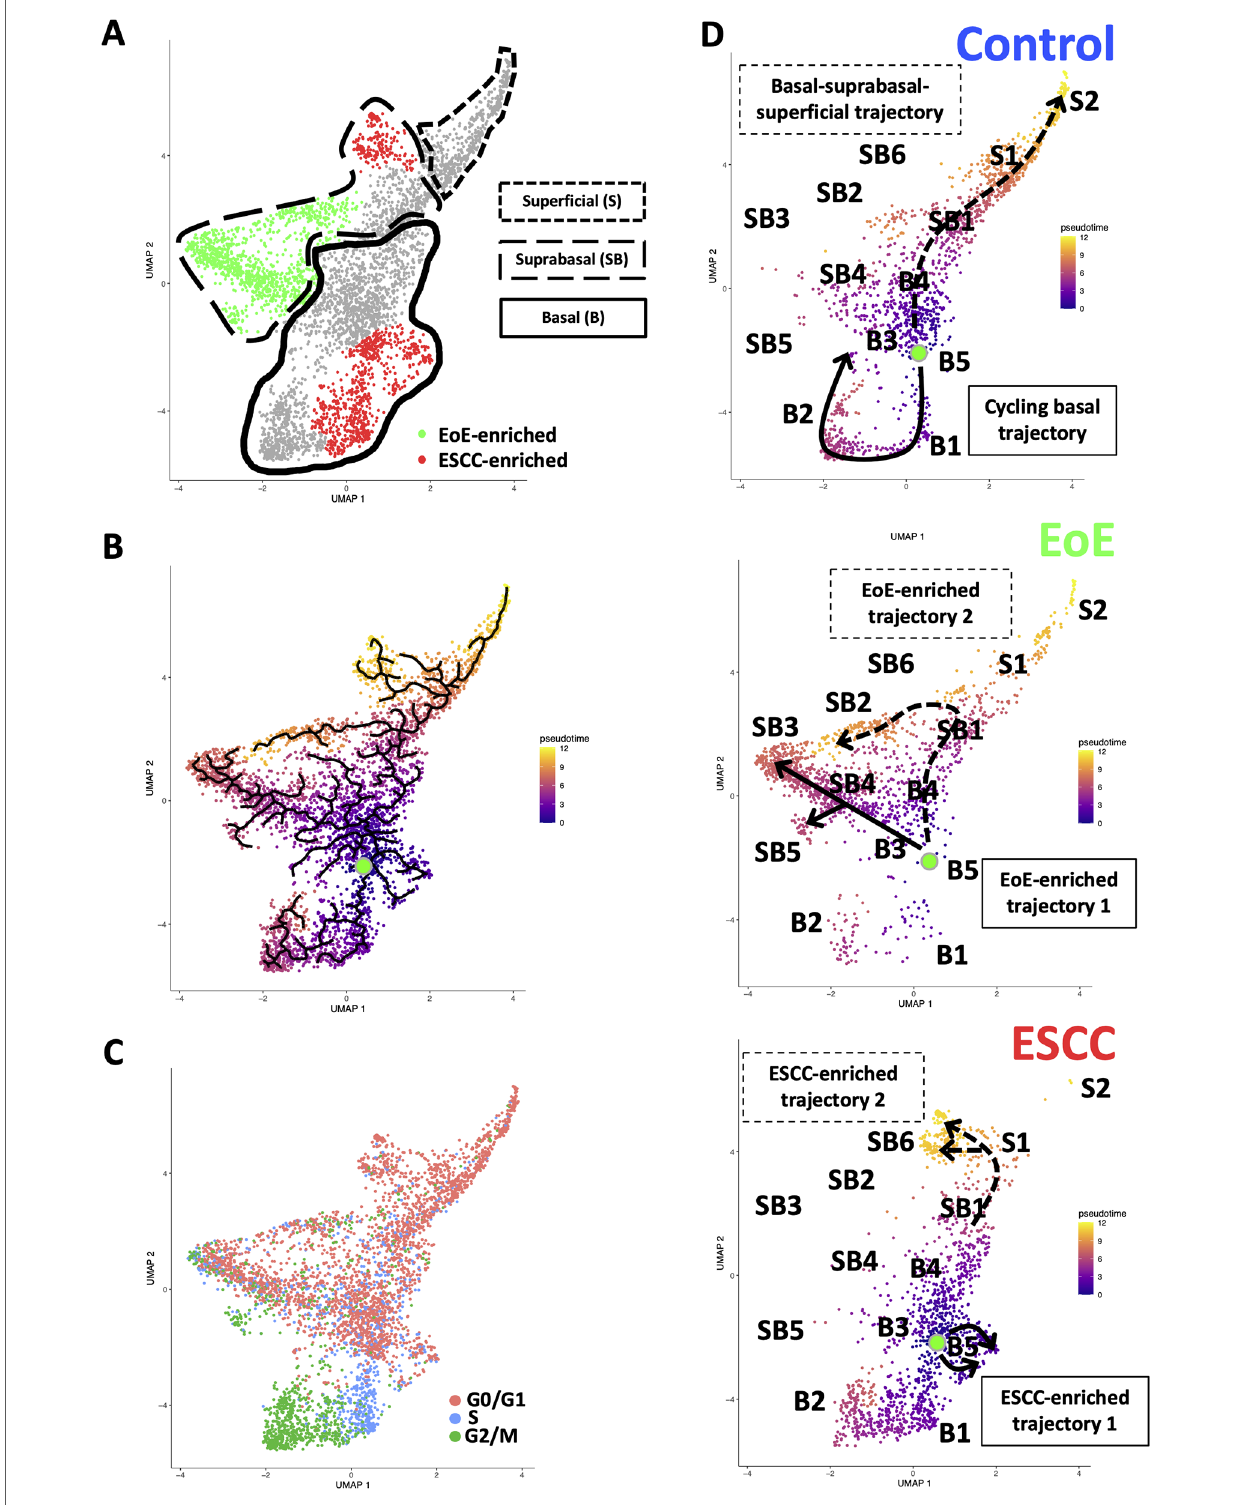
FIGURE 4 Effects of eosinophilic esophagitis (EoE) and esophageal squamous cell carcinoma (ESCC) on esophageal epithelial cell fate. ( A ) Uniform Manifold Approximation and Projection plot (UMAP) of entire single cell RNA-Sequencing dataset with cell populations found to be signi fi cantly enriched in mice with EoE or mice with ESCC colored green or red, respectively. Basal cells are enclosed in solid lines, suprabasal cells are enclosed in dashed lines, and super fi cial cells are enclosed in lines made of square dots. ( B ) Monocle3 UMAP visualization of all cells in single cell RNA-Sequencing dataset. Each cell is colored by its inferred pseudotime value with dark purple representing the earliest cells and bright yellow representing the latest cells in the trajectory. Green dot indicates supervised pseudotime root. Black lines represent putative cell fate trajectories. ( C ) Expression of genes associated with each phase of the cell cycle were labeled on UMAP. ( D ) Pseudotime projections of cells from untreated controls or mice with EoE or ESCC. Lines indicate predicted trajectories with trajectory names noted. Identi fi cation numbers show the location of individual basal ( B ), suprabasal (SB), and super fi cial ( S ) cell populations in the pseudotime